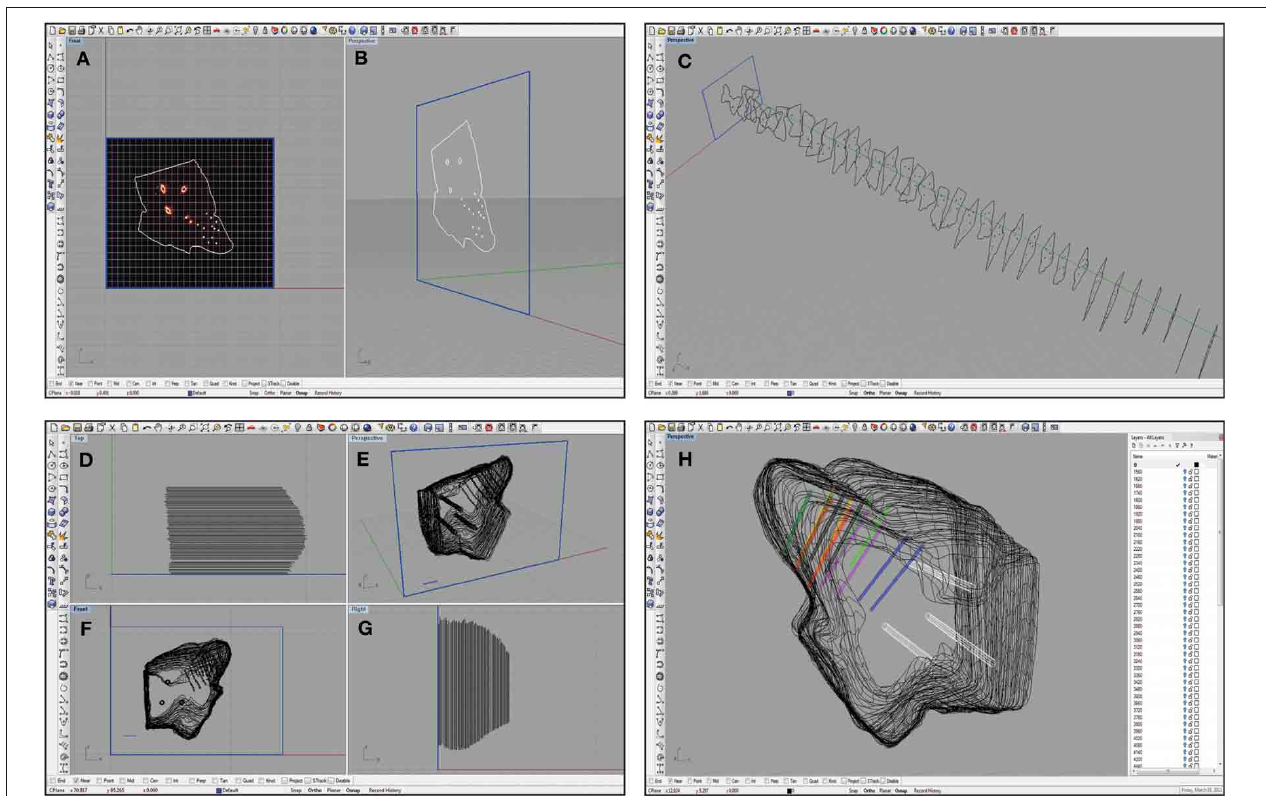
spacing in (D) and (G) indicate where torn slices were removed from the reconstruction. These slices were also scaled using a 1mm ruler (shown in blue; E and F ). Finally, the wireframe was meshed using approximately 50 control points around the shell of the midbrain, and the reference points (white) and electrode array tracks (multiple colors; bi-shank probe pairs are color-matched) were meshed to create tube-like trajectories (H) . The white menu on the right indicates the number of layers that can be turned on or off to increase visualization of specific features at any given